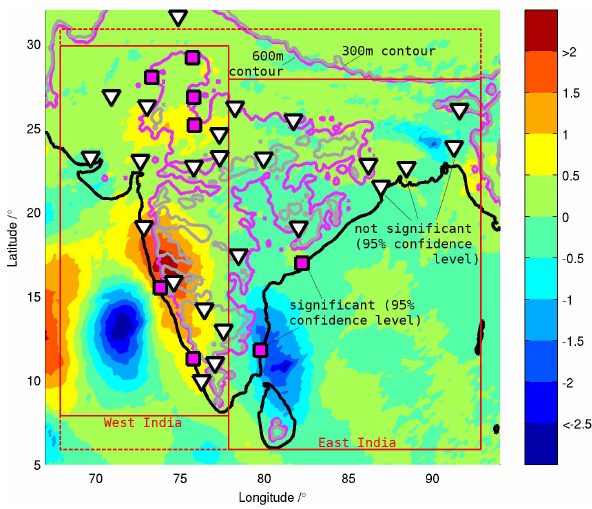
Fig. 5. Shading shows climatological accumulated net water vapour sink p − e (cm/season) calculated from back-trajectories between India and Australia that precipitate first in the West India domain but in greater detail. The correlation between VCD and seasonal mean rainfall is calculated for rain gauges marked by squares and triangles.